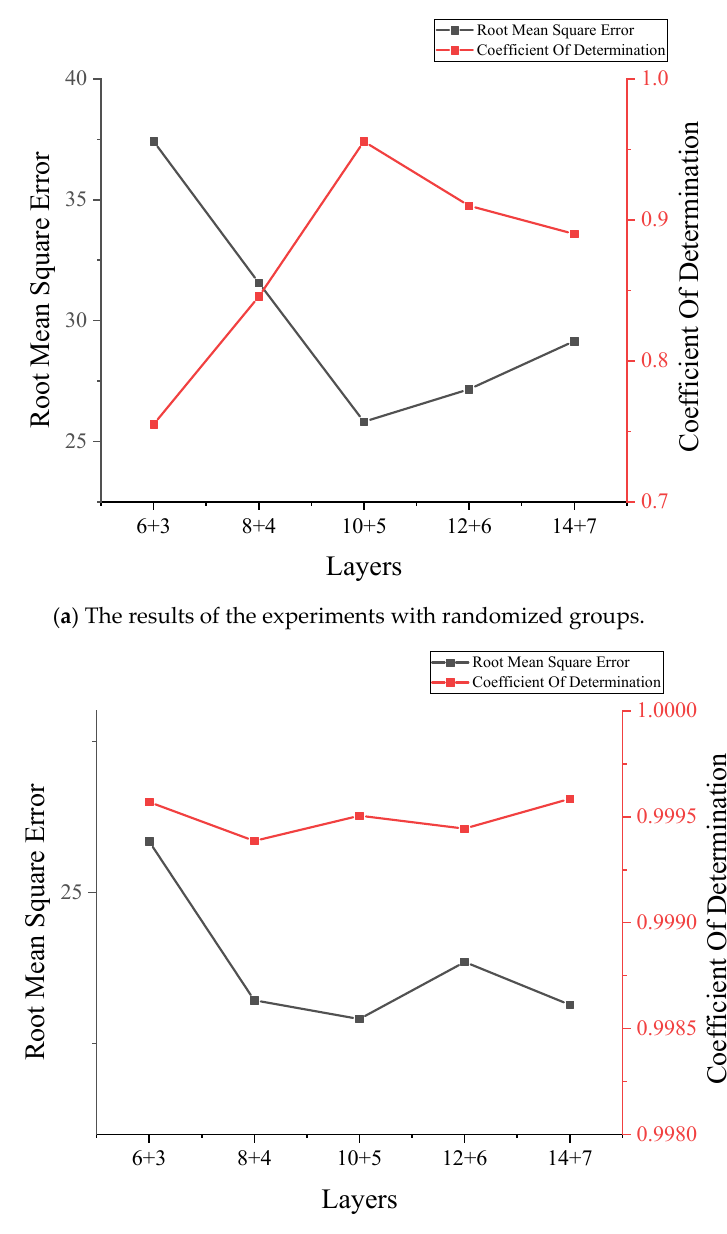
( b ) The results of the experiments with the May data. Figure 3. The comparison of layer combinations. Figure 3. The comparison of layer